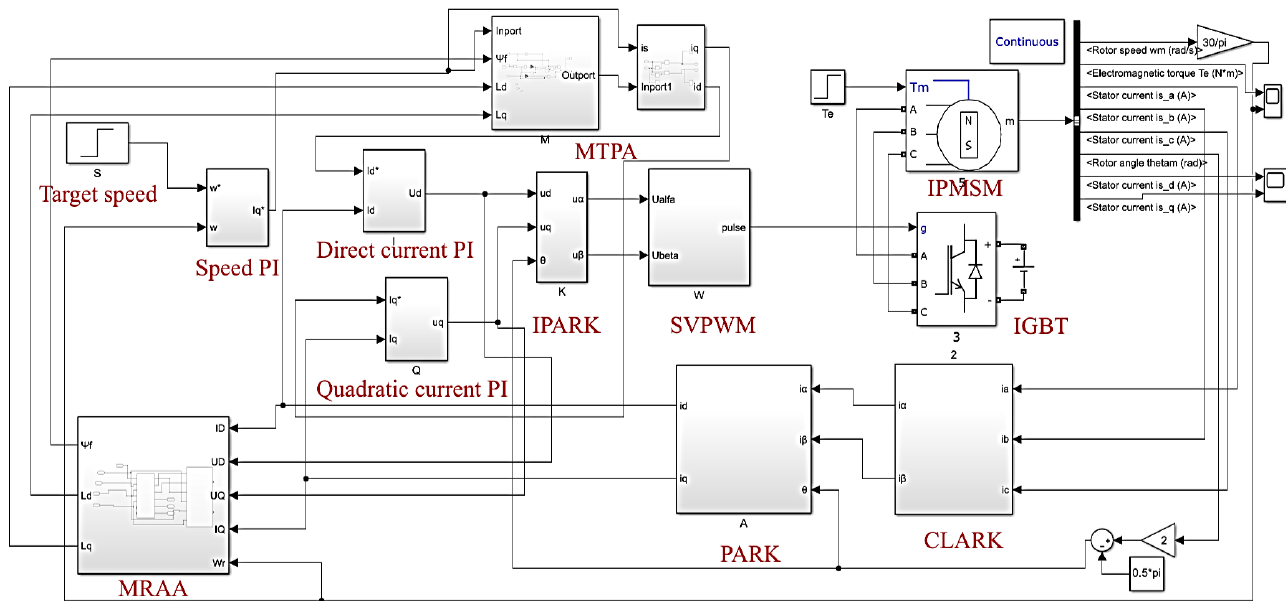
Figure 8. Simulation model of IPMSM MRAA based on Popov hyper stability theory.